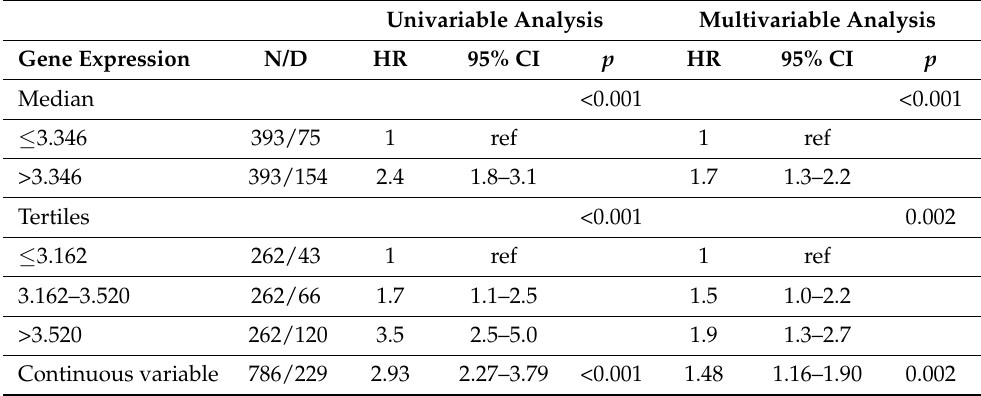
Table 6. Overall Survival of 786 NB patients in relation to TSSC1 expression levels evaluated by the Cox